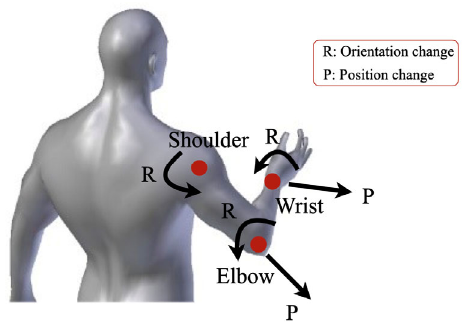
Figure 2. Joint attributions of should, elbow and wrist.